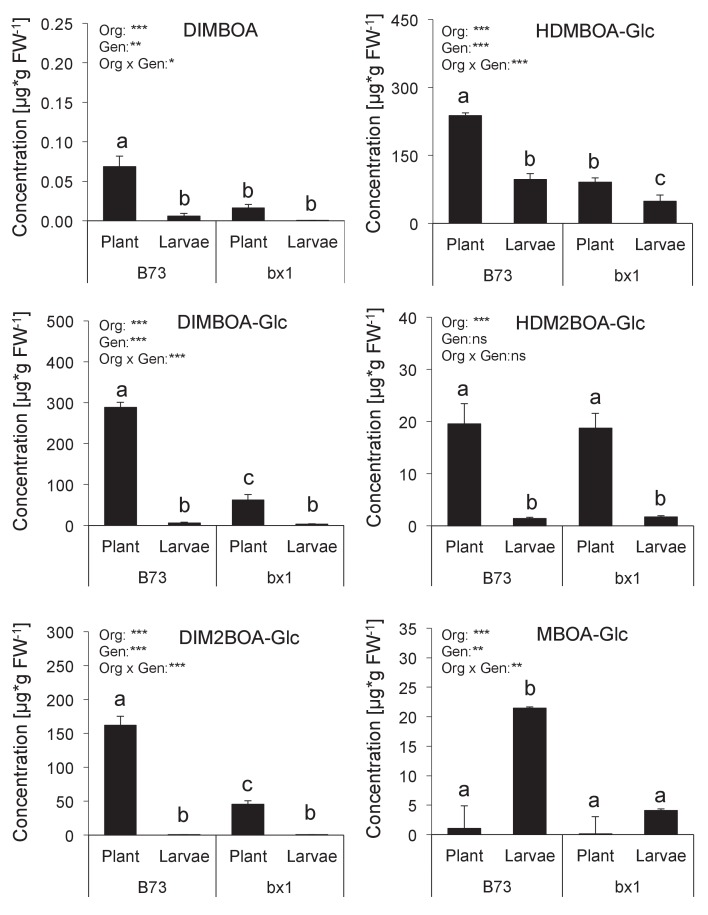
Benzoxazinoid levels in Diabrotica virgifera larvae fed wild-type (B73) and bx1 (bx1:B73) mutant plants.Means ± SE are shown. Results of two-way ANOVAs are shown (*p<0.05, **p<0.01, ***p<0.001). Letters indicate significant differences between genotypes (post-hoc test, p<0.05).